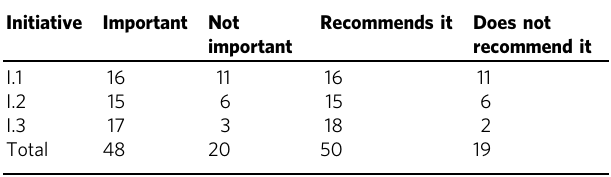
Table 12 Importance and pupils ’ recommendation of the subject for each initiative.